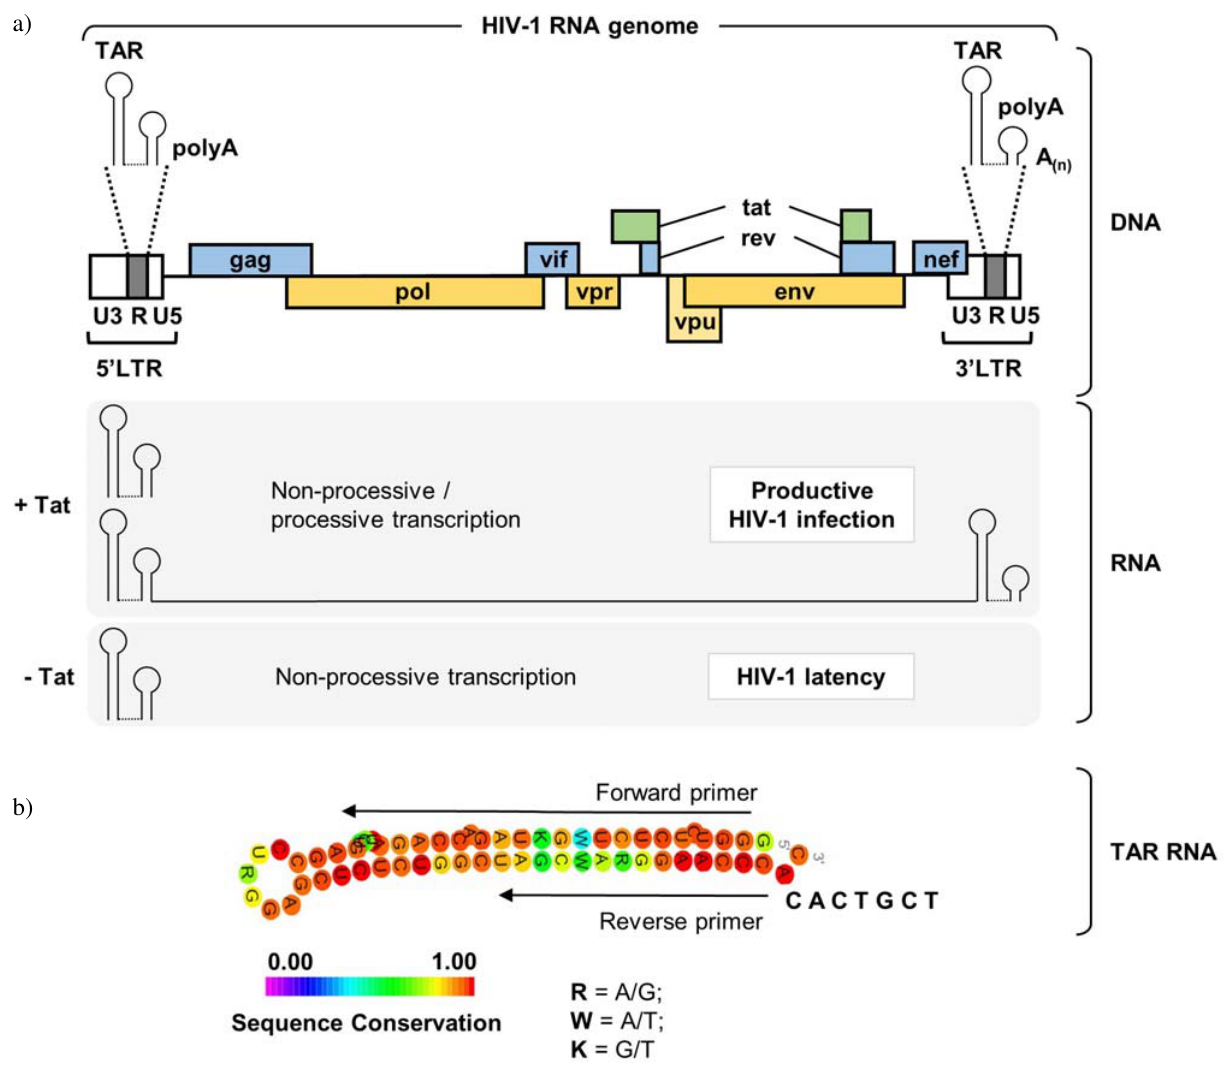
Figure 1. TAR as part of the HIV-1 provirus, HIV-1 genome, and TAR RNA. (a) Scheme of the HIV-1 genome (modified from Harwig et al. 11 ), sho- wing the long terminal repeat (LTR) region divided into the U3, R (including TAR) and U5 domains. In the presence of Tat (+Tat), full-length viral RNA and short TAR RNA molecules are transcribed, while in the absence of Tat (-Tat), only TAR RNA is produced. (b) Structure and sequence conservation of the TAR hairpin (57 nucleotides) with the indicated oligonucleotides used for the specific amplification of TAR